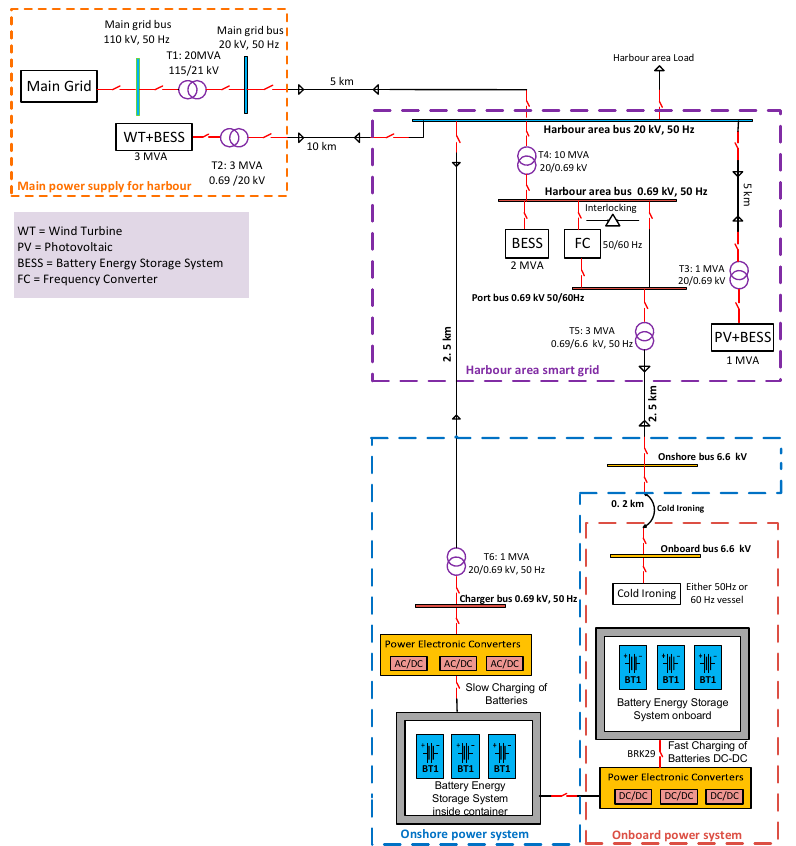
Figure 6. Configuration E: Combination of the container- and vessel-based charging of batteries along with cold-ironing.